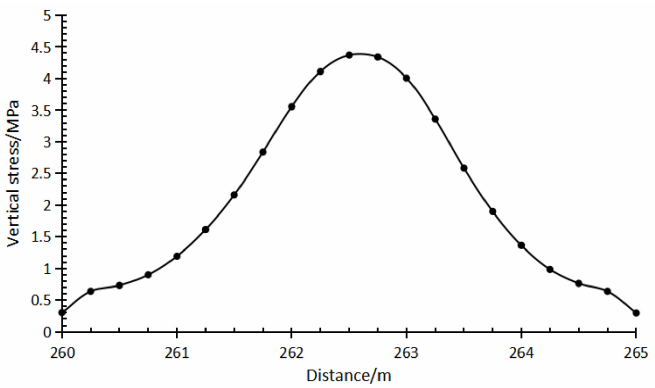
Figure 14. Stress monitoring curve of the small coal